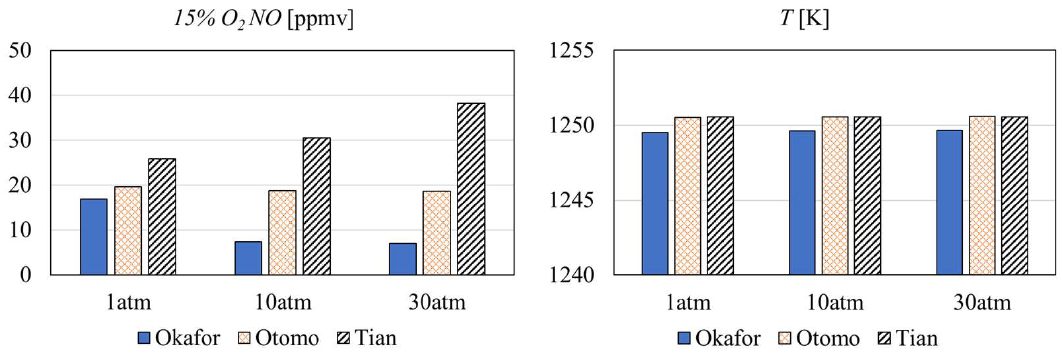
Figure 10. Effects of reactor pressure and chemical mechanism in AS CRN.